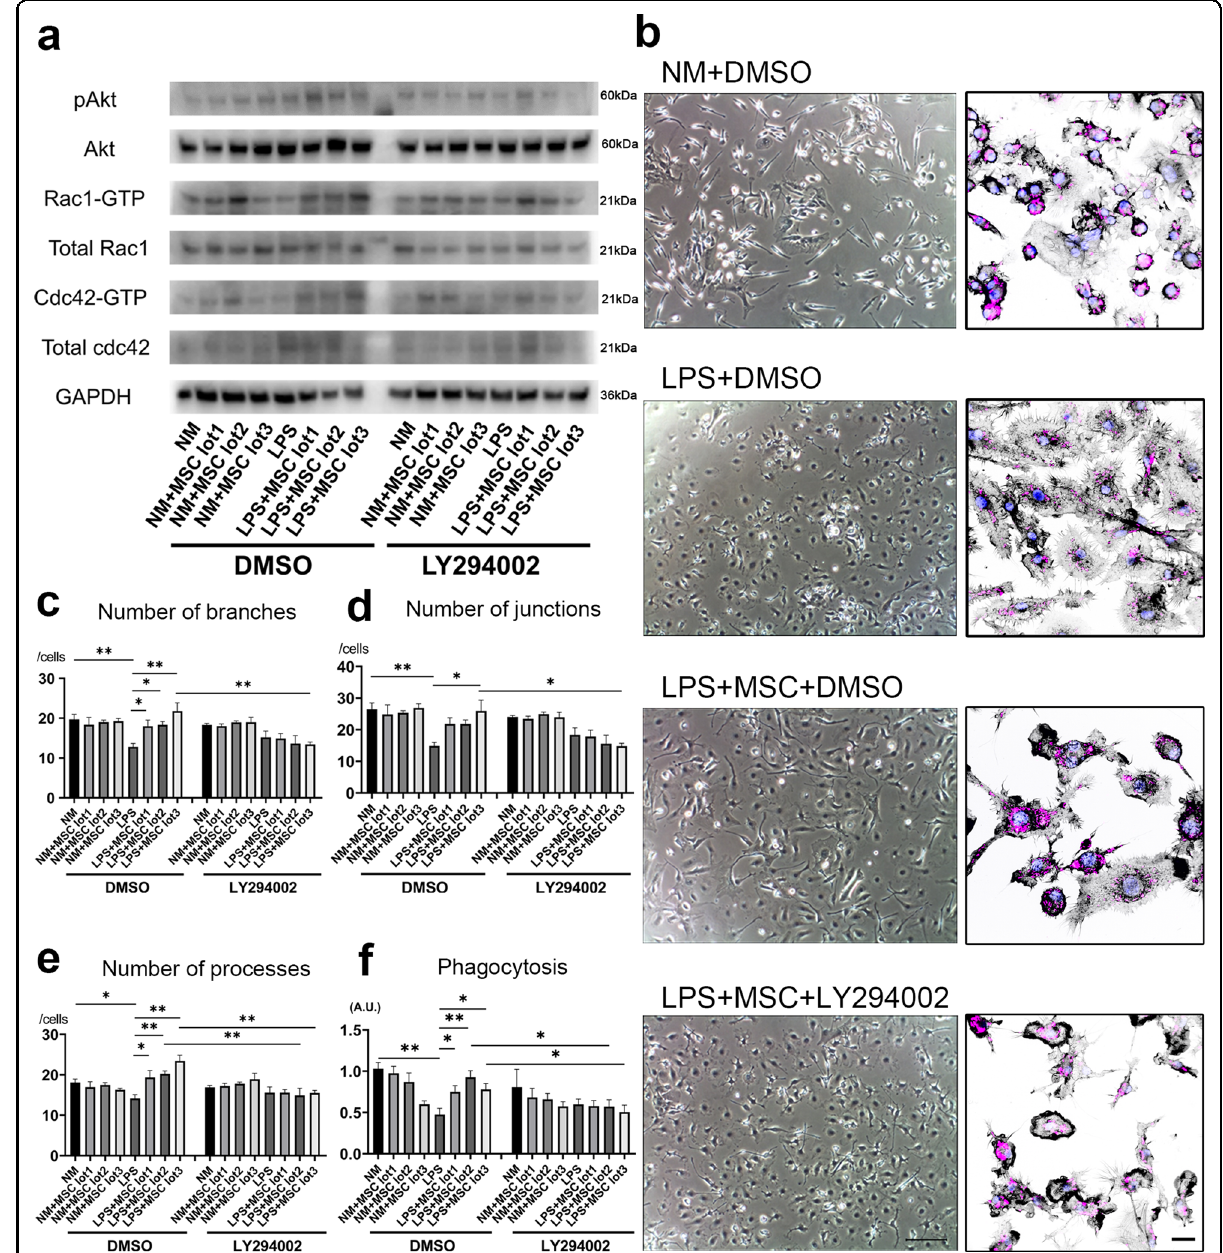
Fig. 6 Inhibition of PI3K-Akt pathway blocked the activation of Rho GTPase and change of phenotype in LPS activated microglia. Western blotting images of pAkt, Akt, and Rho GTPase in 30 min after MSC co-culture. The data represent at least three individual experiments ( a ). Phase contrast images of four groups (scale bar = 100 μ m) and immunocytochemistry of F-Actin (black), bioparticles (purple) and Hoechst 33342 (blue) (scale bar = 20 μ m) ( b ). Quanti fi cation of the number of branches ( c ), junctions ( d ), processes ( e ), and phagocytosis ( f ). (Dunn ’ s multiple comparisons test were used). Data are presented as mean ± SEM with ** p < 0.01, * p < 0.05. Abbreviation: A.U., arbitrary